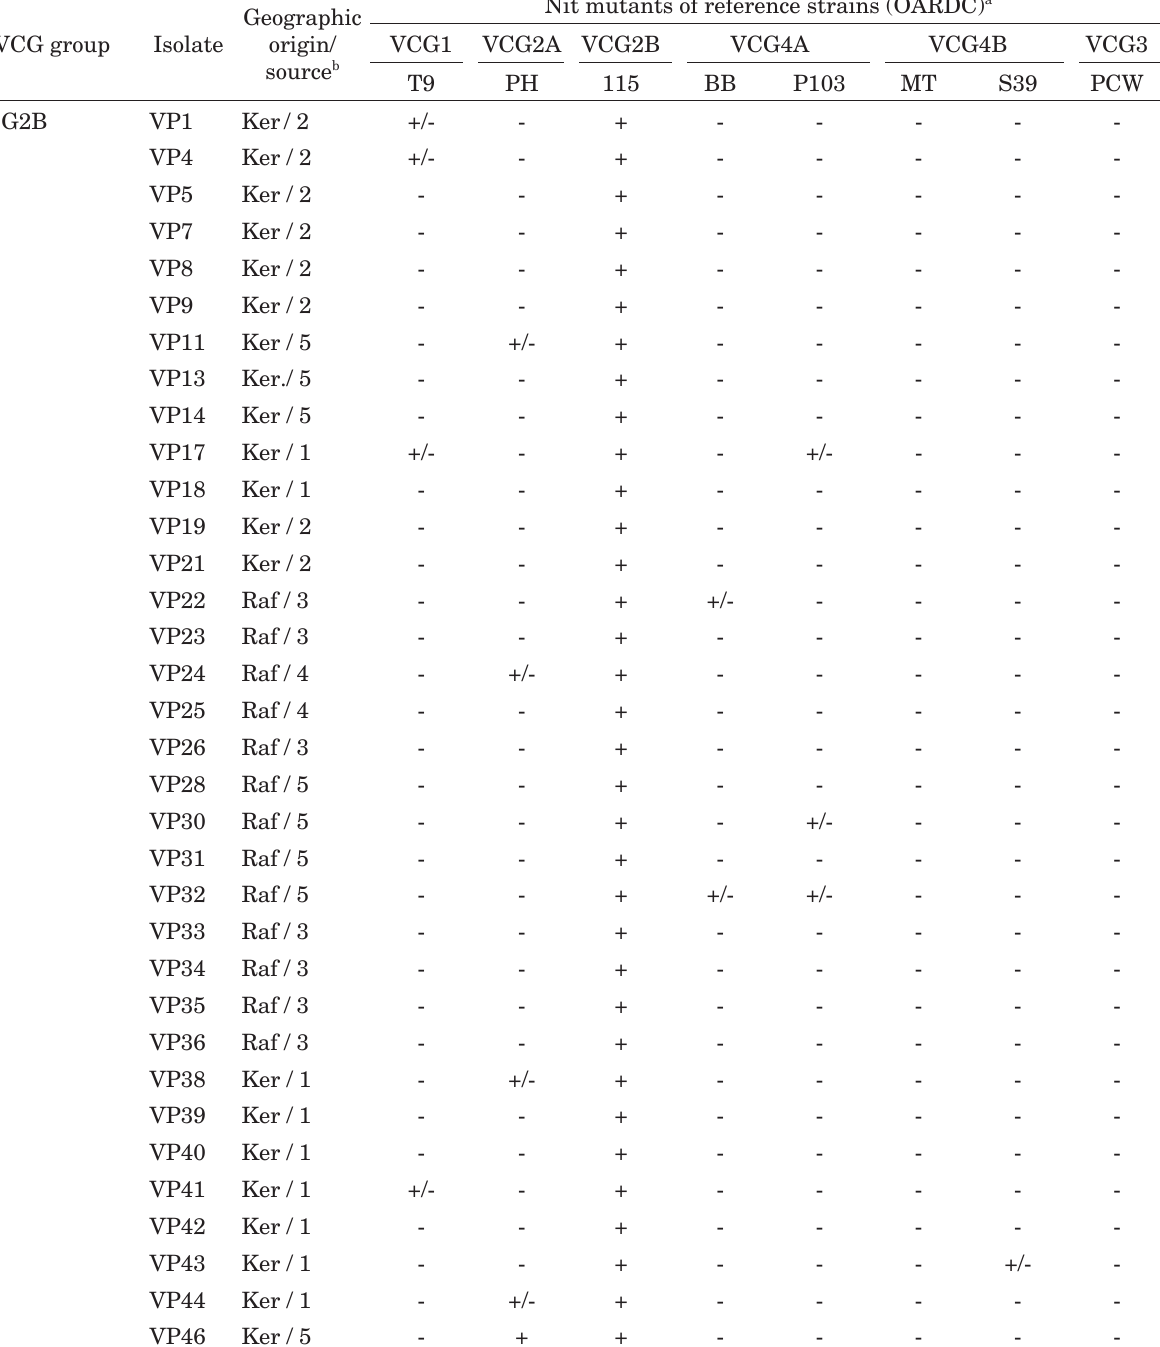
Table 3. Vegetative compatibility groups (VCGs) of Verticillium dahliae isolates from pistachio in Iran using international tester